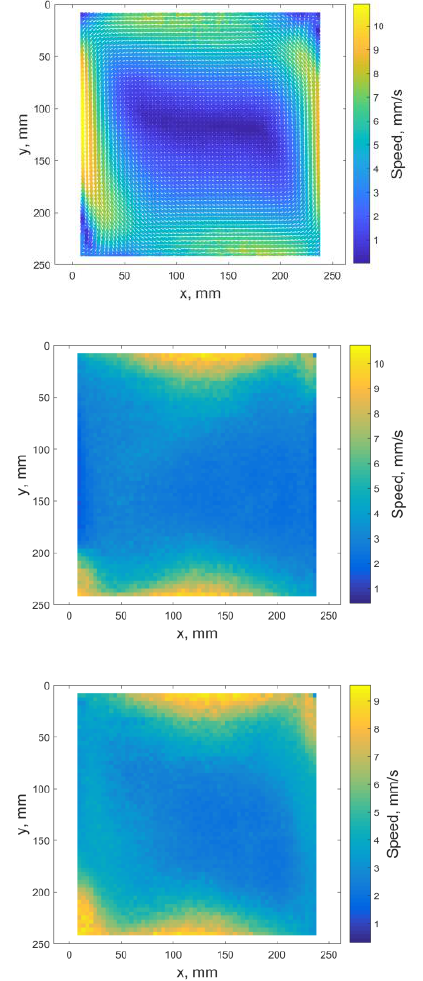
Fig. 2. Average velocity field (top) and a field of standard deviations for horizontal (middle) and vertical (bottom) velocity